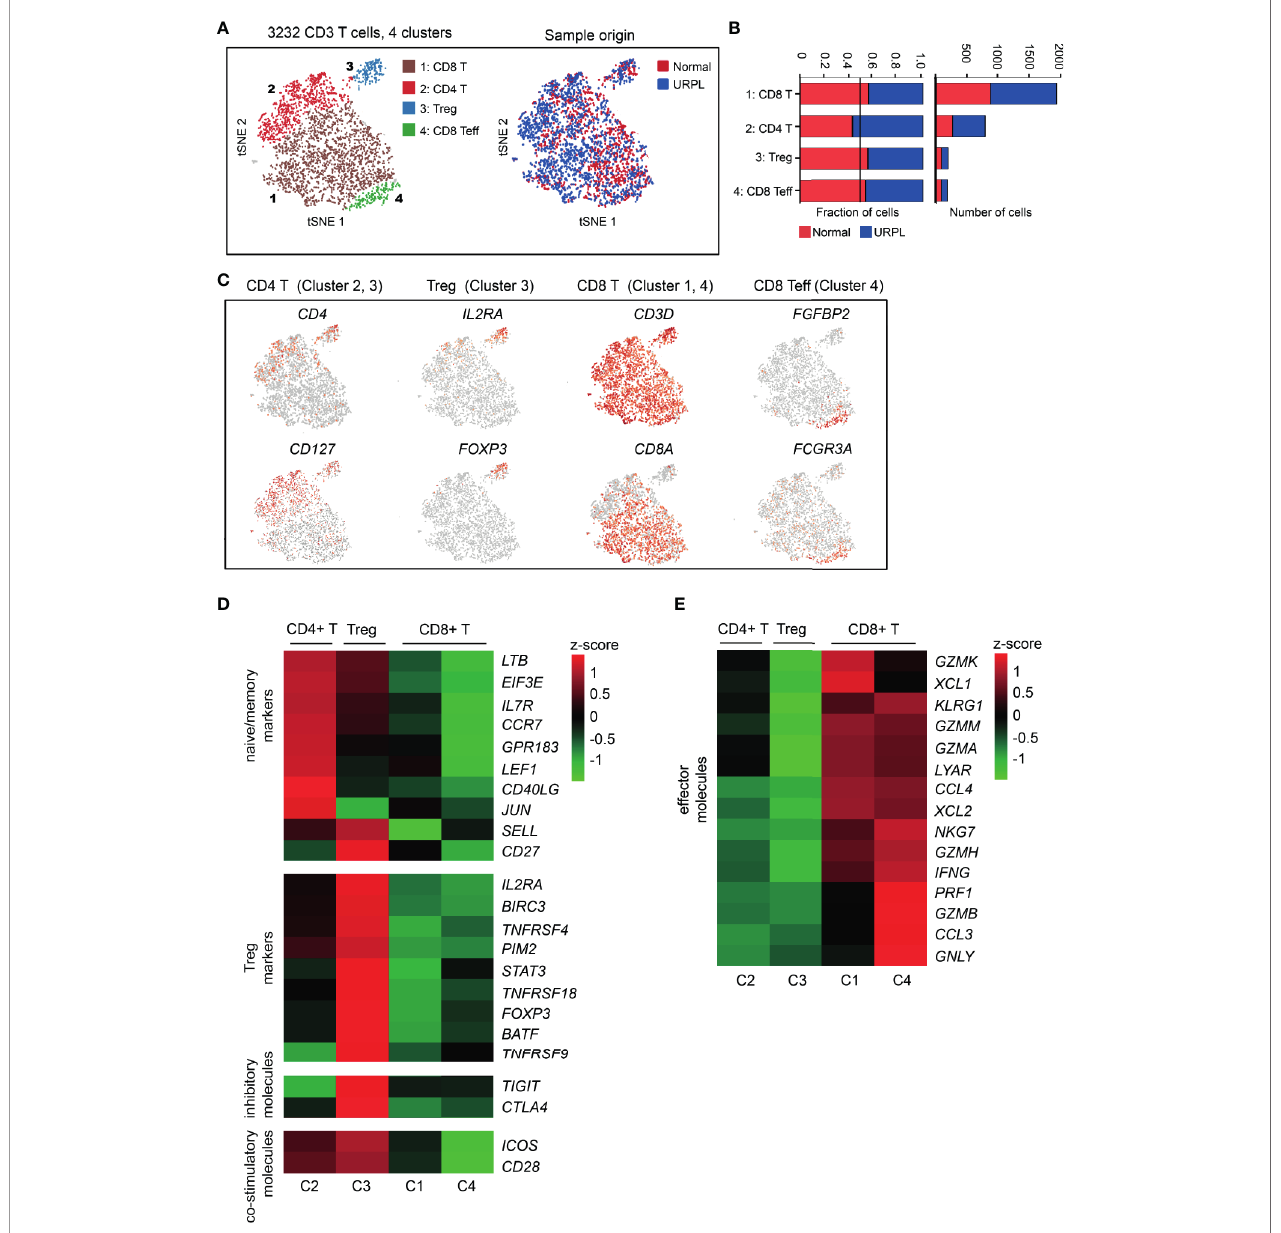
FIGURE 4 | Single-cell data revealed molecular details and subclusters of decidual T cells. (A) tSNE of the T cells as de fi ned in Figure 1A , with each cell colorcoded for (left to right): the associated cell type and its sample type of origin (normal or URPL). (B) The fraction of cells originating from URPL and normal control samples for the 4 subclusters above. (C) Expression of marker genes for the cell types above. (D, E) Heatmap depicted the gene expression of (D) naïve/ memory markers, Treg markers, immune inhibitory molecules and co-stimulatory molecules, (E) effector T cell molecules in 4 subclusters above. Gene expression was is measured in units of log2. Analysis of gene expression in scRNA-seq data was performed in R (version 3.5.2) using